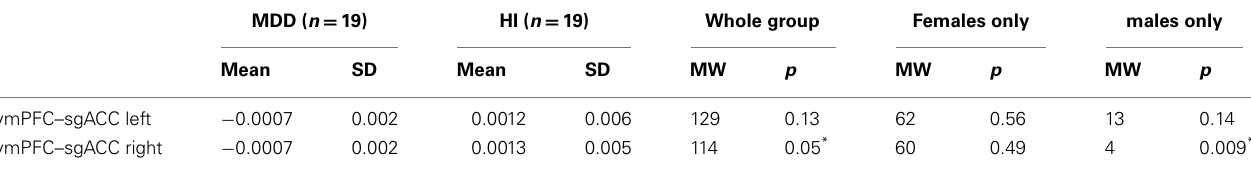
also indicate greater activity in leftACC and right lateral prefrontal cortex to positive emotional stimuli in females with MDD ver- sus healthy females (Mitterschiffthaler et al., 2003). Another study showed greater left ACC and left dorsolateral prefrontal cortical activity (Wagner et al., 2006) and greater effective connectivity between left dorsal and rostral ACC during performance of